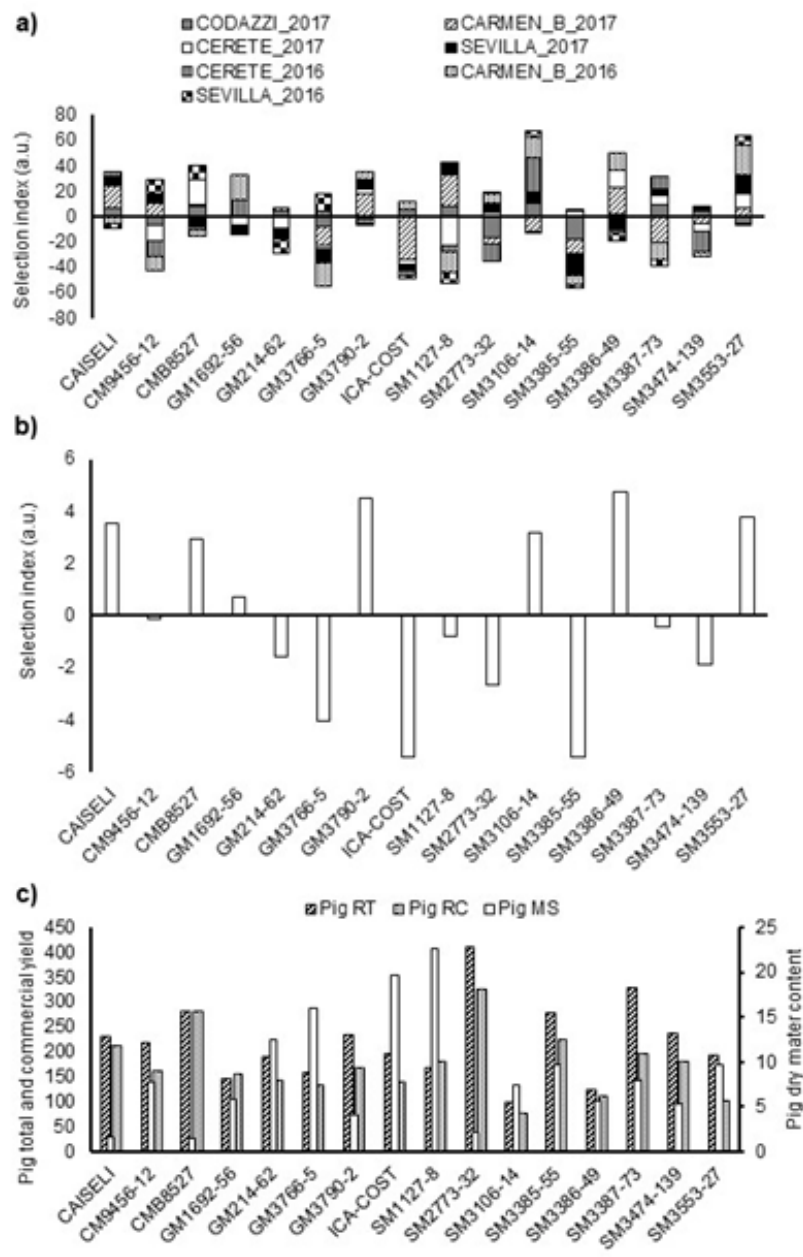
Figure 4. Multi-factorial response of genotypes evaluated in multiple Caribbean conditions. ( a ) Genotype selection index in the environment. ( b ) General selection index of genotypes evaluated in multiple environments. ( c ) Lin and Binns superiority index for the total and commercial yields and dry matter content.